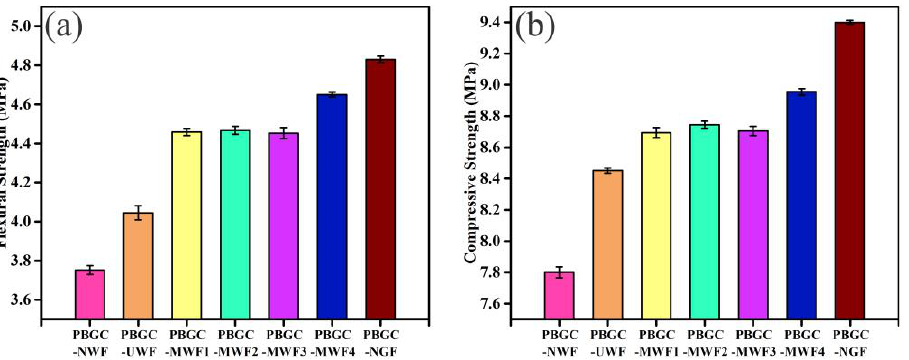
Figure 12. Effects of the different MWF and NGF on the mechanical properties at fixed WF contents of 1.0 %. ( a ) Flexural strength; ( b ) Compressive strength.